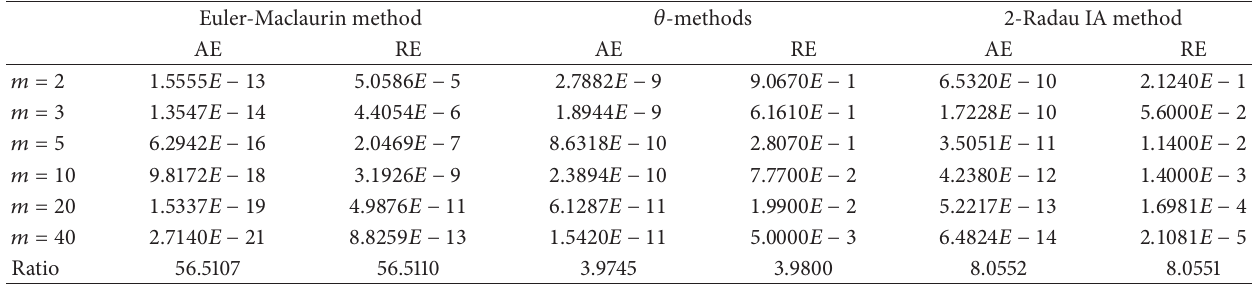
Table 1: Errors and ratio for (37).